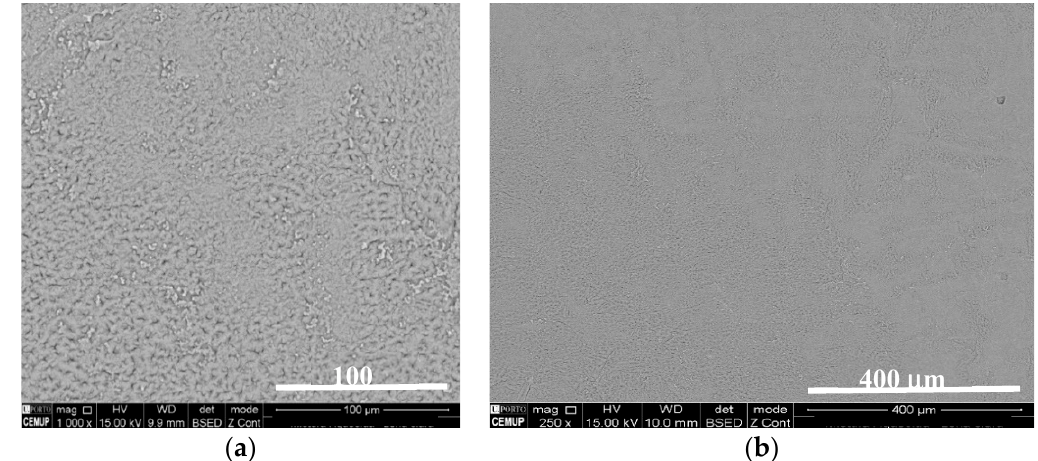
Figure 3. Ferroelectric composite (80% Na-glass electrolyte + 20% polyvinyl acetate PVAc-C 4 H 6 O 2 ) SEM microphotographs (backscattered radiation). Magnification: ( a ) 250×; ( b ) 1000×.